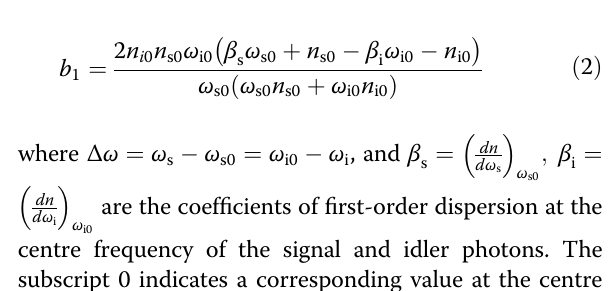
(ICCD) camera. The simulations of the interference pat- terns from calculating the phase mismatch are shown in Fig. 3b (the simulation is based on equations (S3) and (S6) in Section 2 of Supplementary Information, in which a small-angle approximation is used).